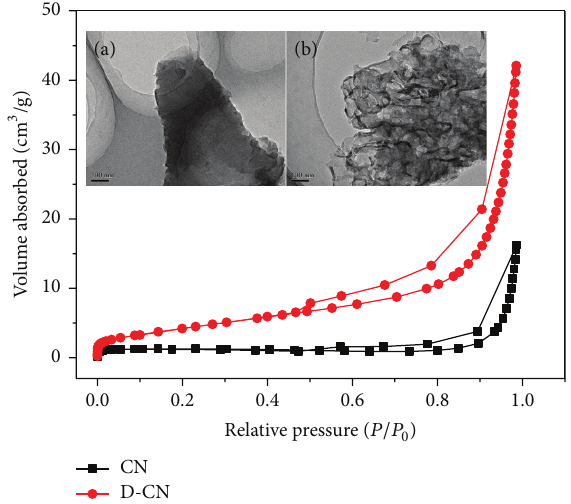
Figure 3: N 2 adsorption-desorption isotherms of CN and D-CN. Inset is the TEM images of (a) CN and (b) D-CN